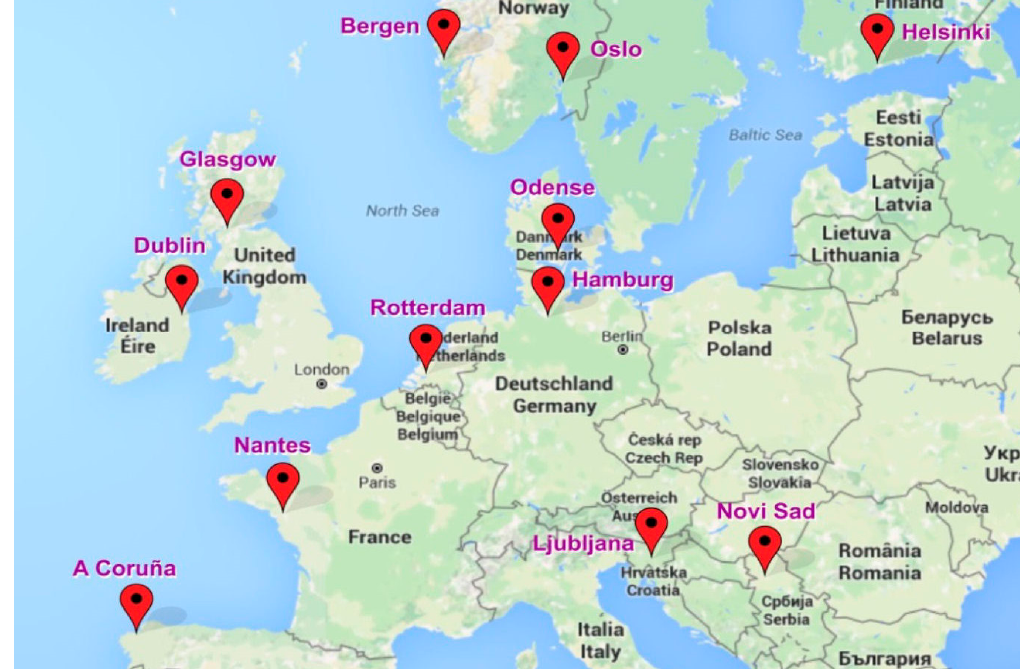
Figure 1. A map of the main cities studied in the COST Project.